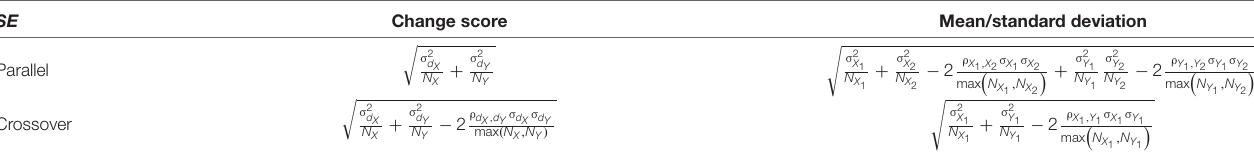
TABLE 2 | Calculation of standard error based on the type of information (change score vs. mean/standard deviation) and the type of experiments (parallel vs. crossover).